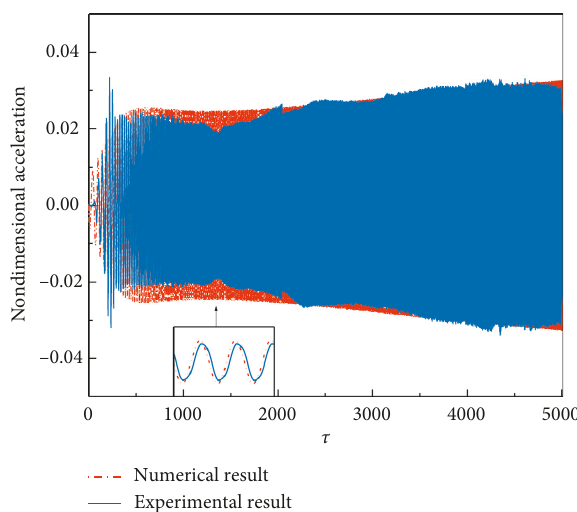
Figure 6: Comparison between the numerical and experimental results.